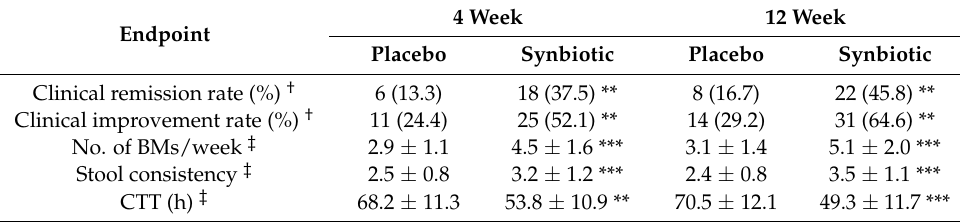
Table 2. Clinical outcomes of treatment vs. placebo